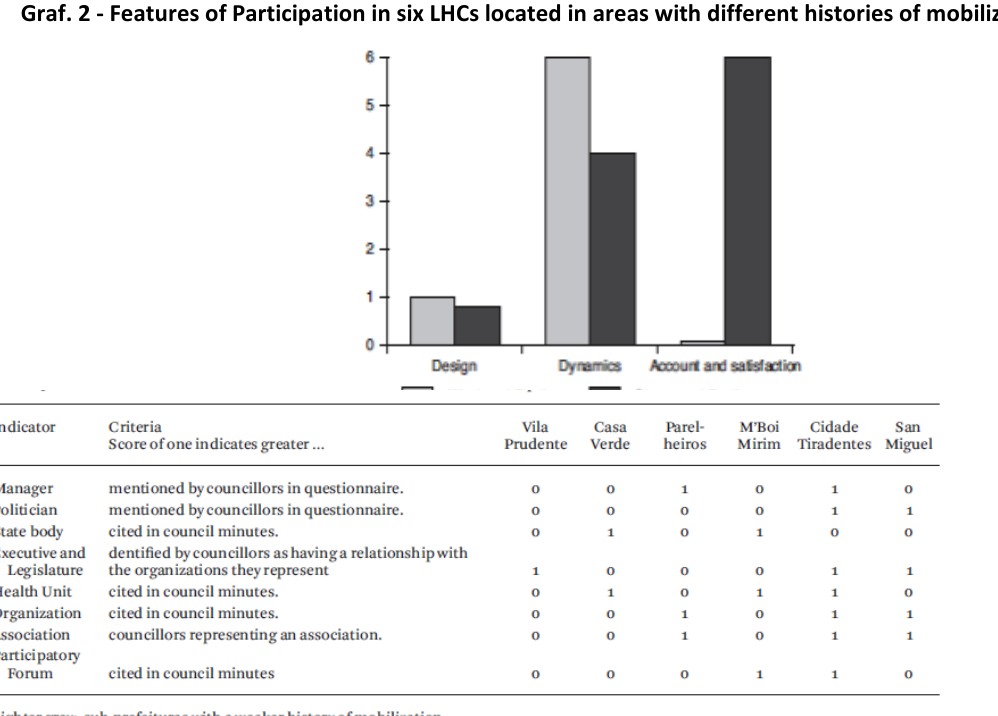
Graf. 2 - Features of Participation in six LHCs located in areas with different histories of